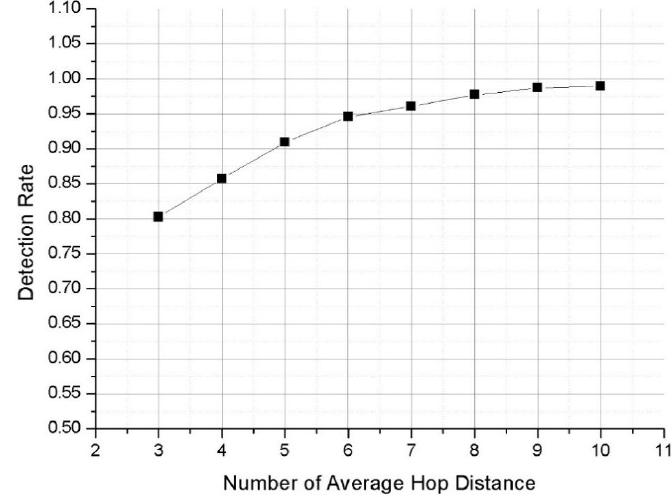
Figure 13. Simulated detection